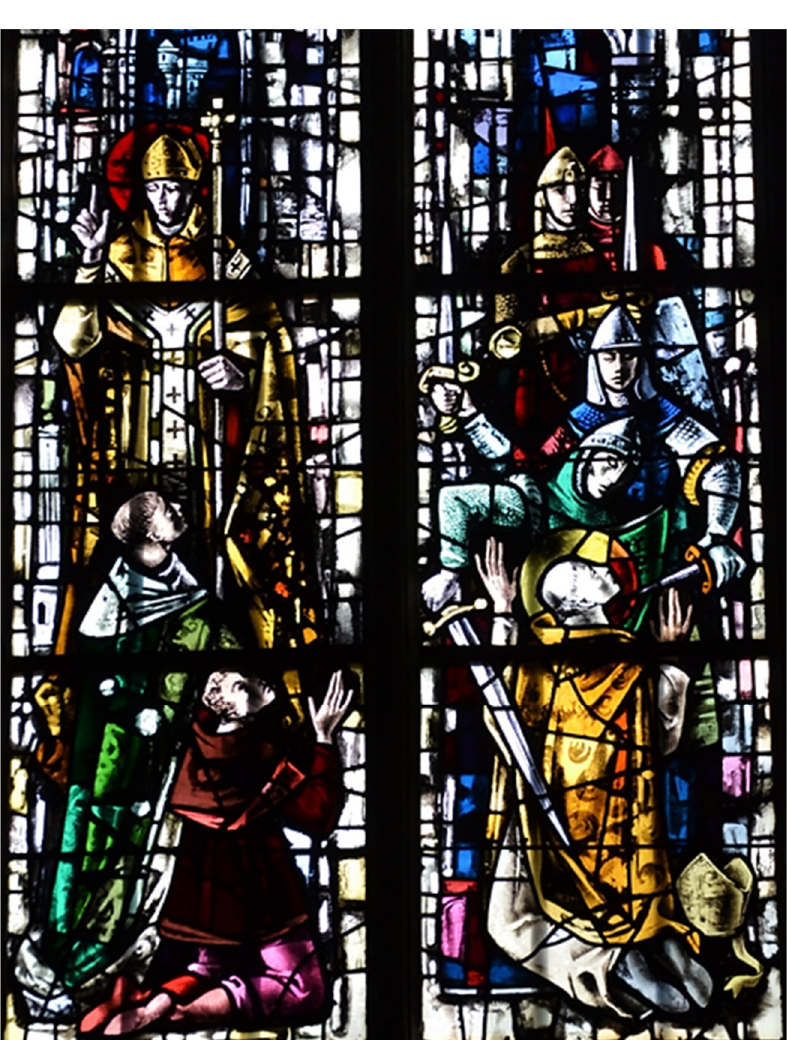
Figure 15. Saint-Lô, Church of Notre-Dame, Saint-Thomas chapel, Life of Saint Thomas window, 1968, detail, Archbishop Thomas returns to Canterbury and Murder of Archbishop Thomas. © author.